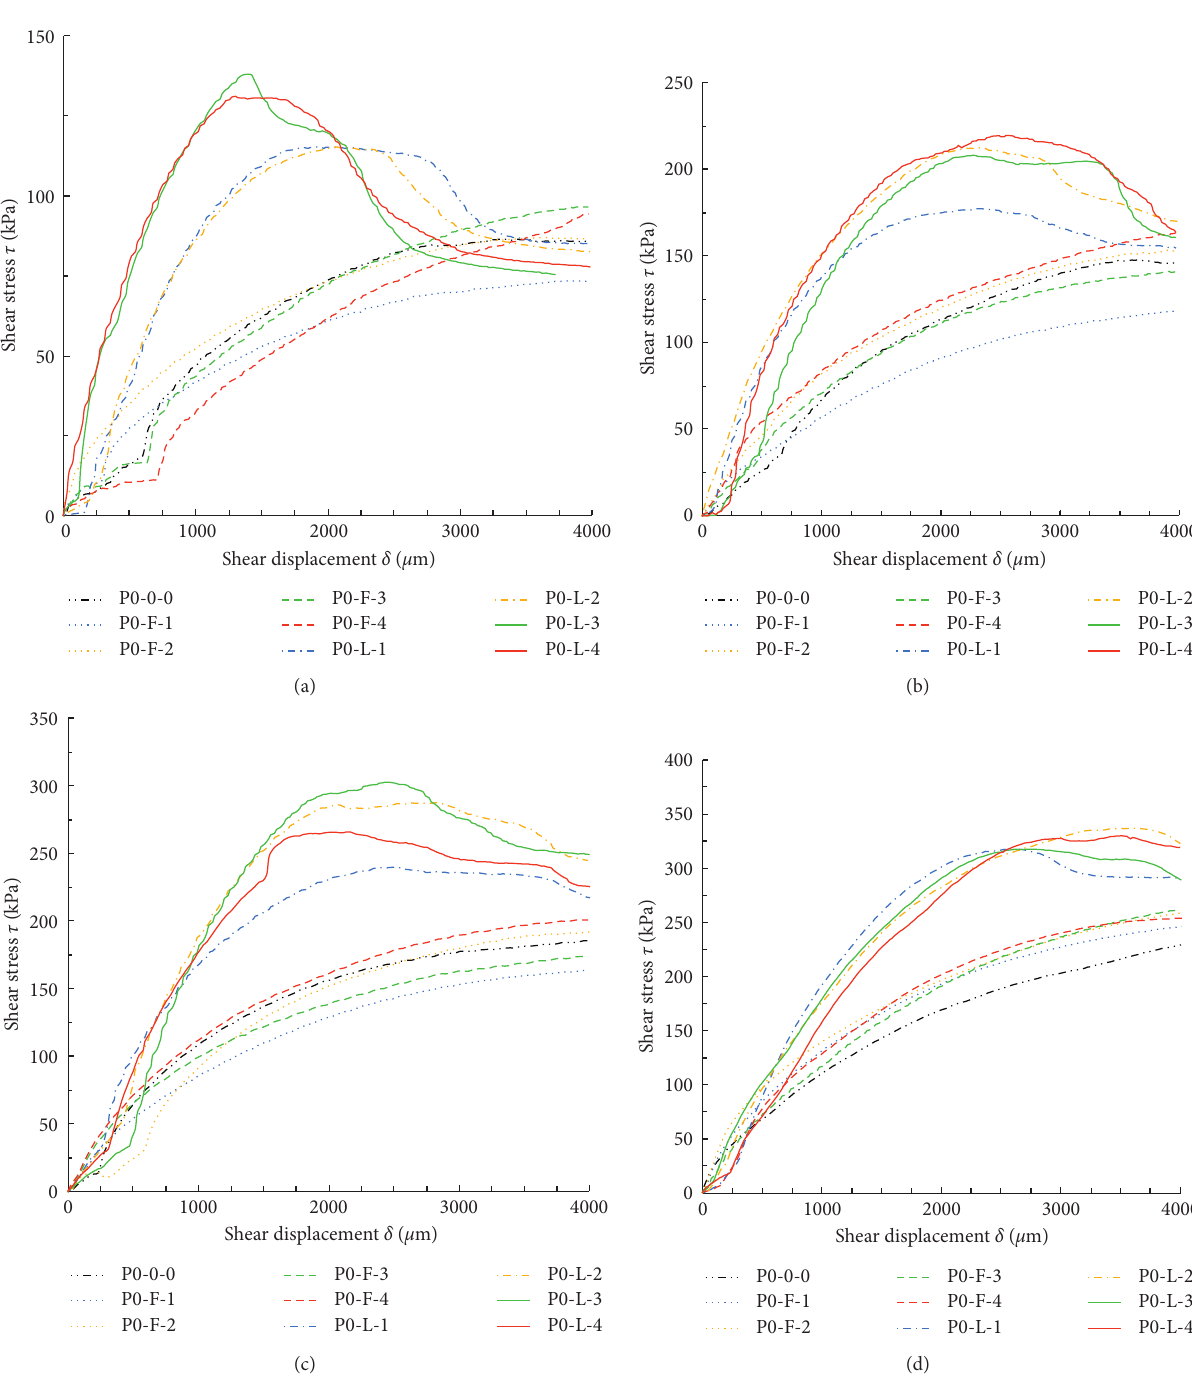
Figure 2: τ - δ curves of the modified iron tailings with the 1 freeze-thaw cycle: (a) 100 kPa normal stress, (b) 200kPa normal stress, (c) 300kPa normal stress, and (d) 400kPa normal